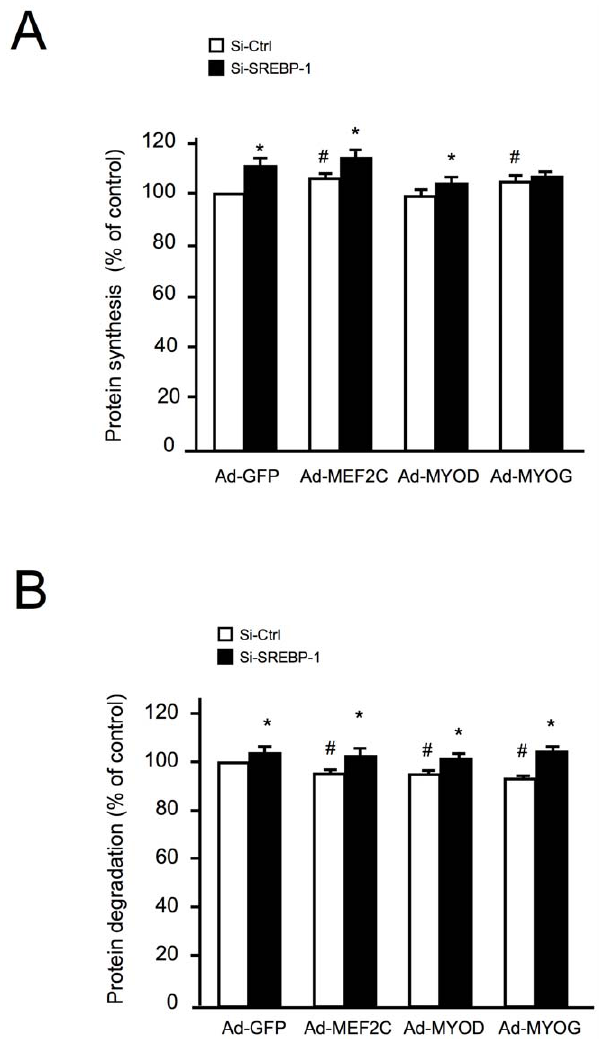
Figure 3. siRNA-mediated inhibition of SREBP-1 affects protein synthesis and degradation rates. Protein synthesis and degrada- tion rates were determined in human primary myotubes under GFP or MRFs overexpression. Cells were transfected with siRNAs (control or against SREBP-1) and infected with recombinant adenovirus for 48 hours. The results are the means 6 SE of 4 determinations. *p , 0.05 compared to Ad-GFP infected cells. # p , 0.05 compared to control